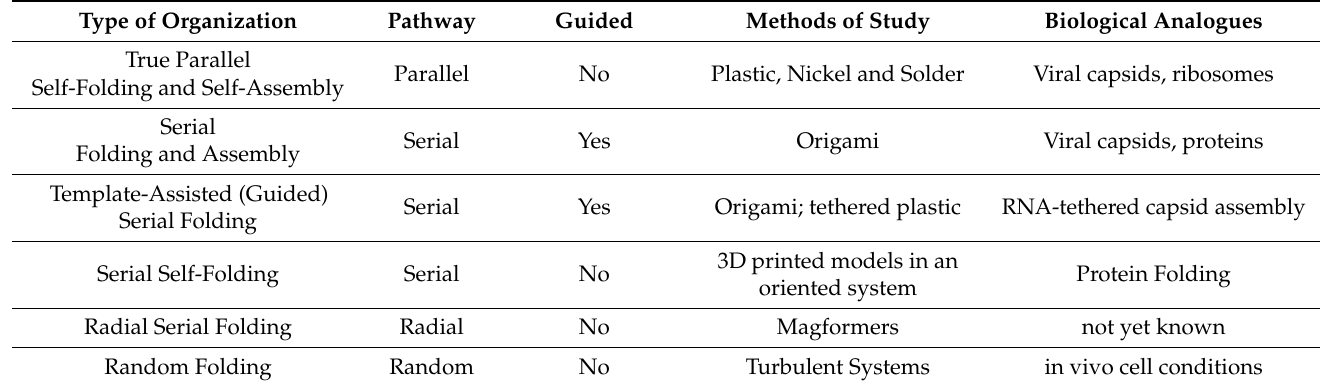
Table 1. Classification of assembly and folding approaches to constructing